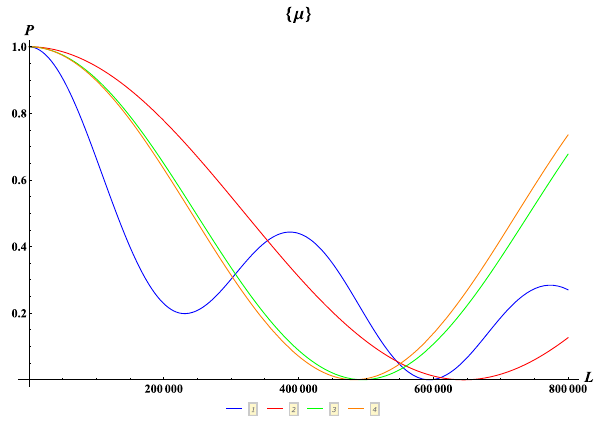
Fig. 13 Comparison of the results for the total muonic neutrino sur- vival probability in a theory without LIV and in models with LIV cor- rections, corresponding to three different values of the δ f kj parameters, as illustrated in Fig. 10. Also the color code is the same adopted in Figs. 10, 11 and